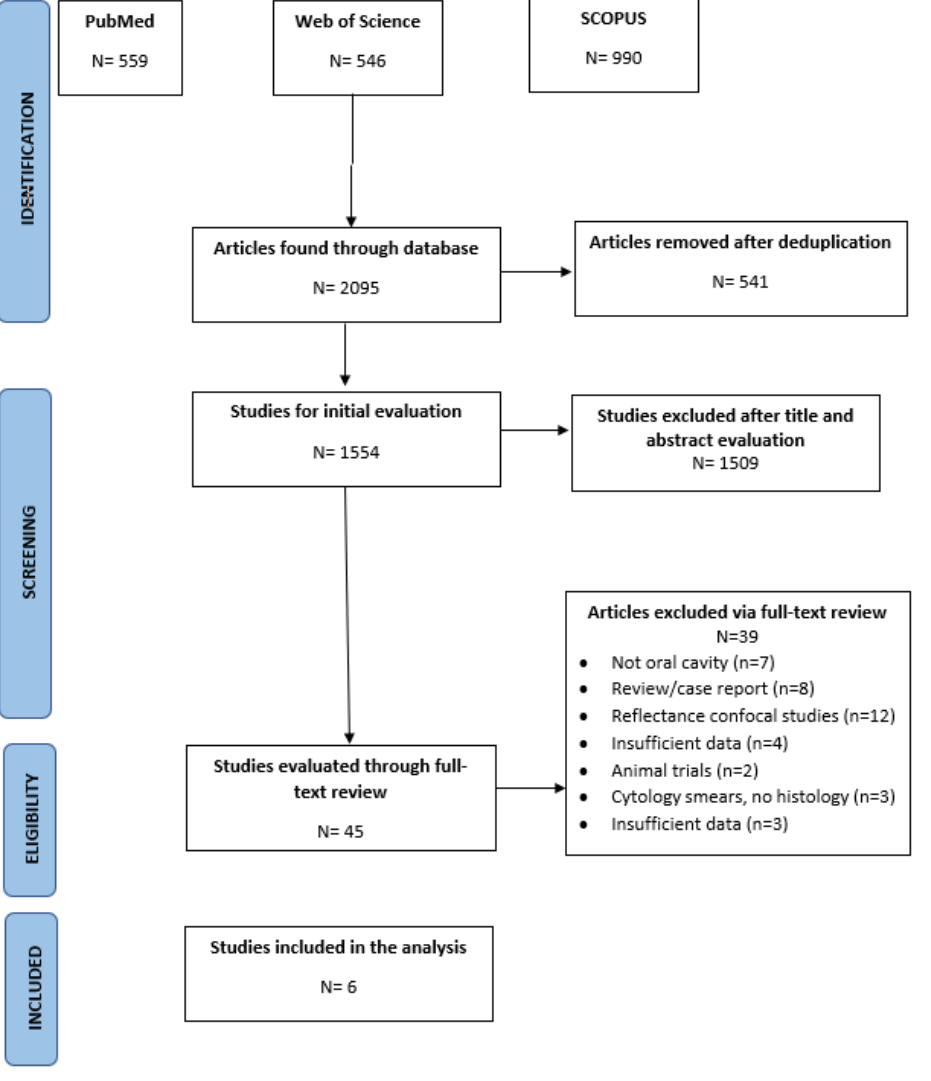
Figure 1. Screening process and results. Oral squamous cell carcinoma (OSCC).